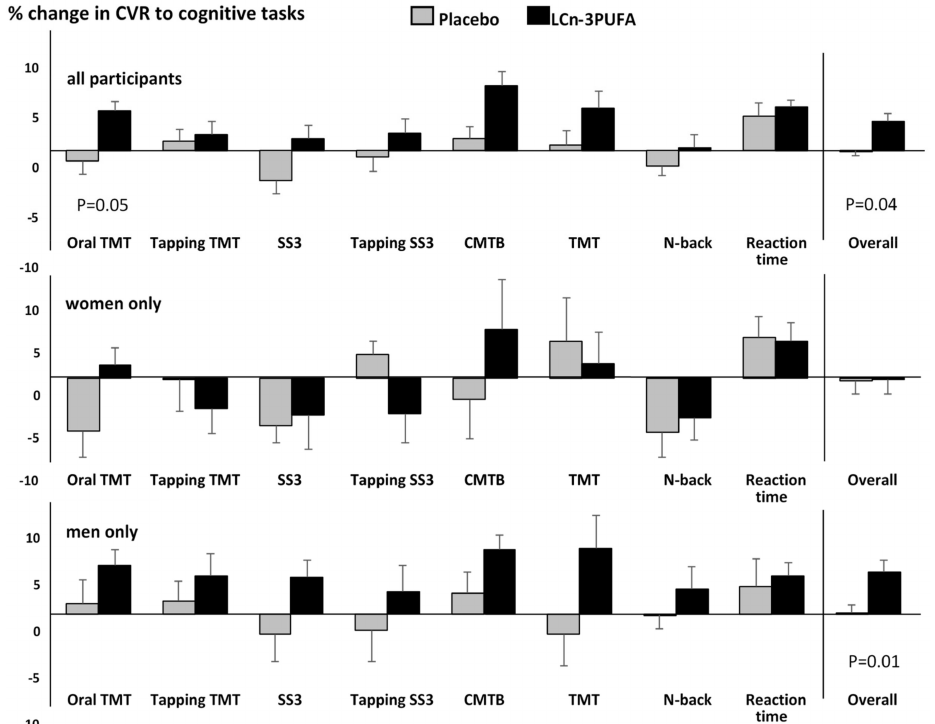
Figure 3. Treatment differences in CVR to the cognitive test battery. TMT—Trail Making Task;